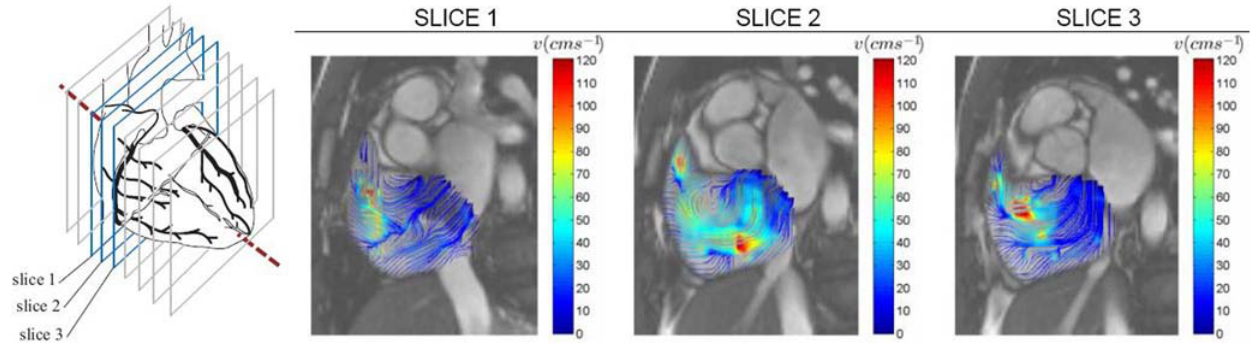
Figure 3. Slices 1 to 3 based on time frame 12 of post-atrial septal occlusion (ASO) scans. Color streamlines demonstrating blood swirl within segmented right atrium for post-ASO at three scan slices of heart is displayed here. Their vortices are presented for three consecutive slices. The reconstruction of these planar information can give a three dimensional perspective of the helix in the right atrium.